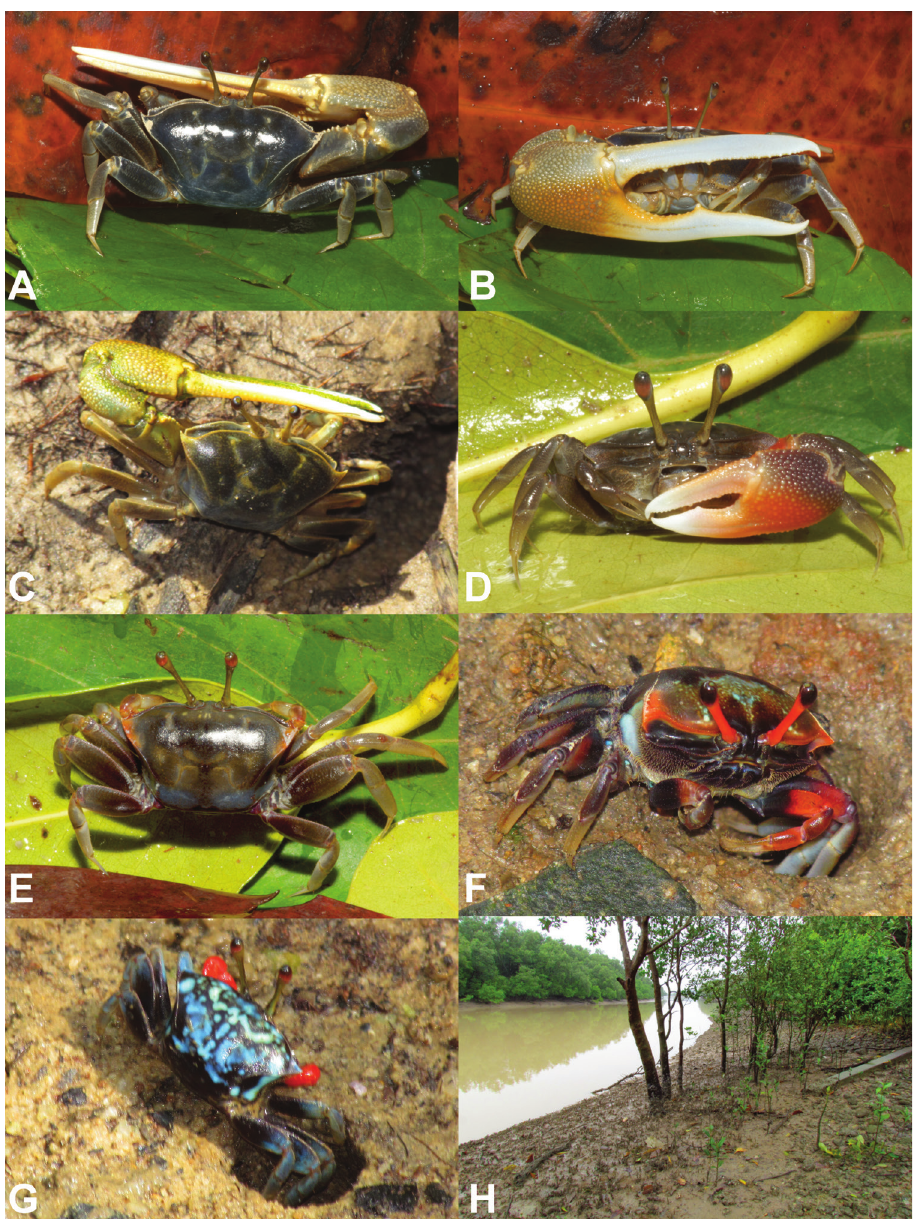
Figure 6. Tubuca alcocki sp. n. A–G variation of the live colouration. A, B holotype (CW 30.1 mm, ZRC 2017.1278; Thailand) C adult male (not collected; Phuket, Thailand) D young male (CW 13.0 mm, NCHUZOOL 14897; Thailand) E ovigerous female (CW 19.8 mm, NCHUZOOL 14897, Thailand) F, G females in the field (not captured; Phuket, Thailand) H habitat in Ranong,